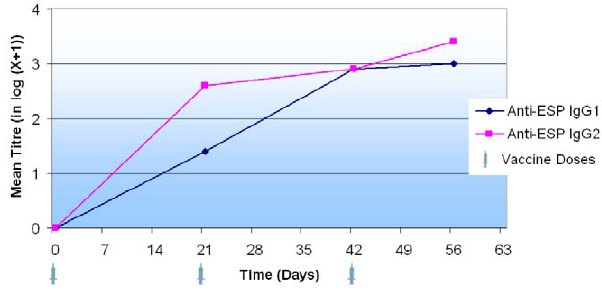
Figure 1. Progression in log-transformed anti-ESP IgG1 and IgG2 titres during the onset of immunity. The data presented here are the means of the log-transformed titres. The titre is taken to be the first dilution with an optical density of less than 0.4 measured at 405 nm. The sera were tested using an ESP-coated ELISA at days 0, 21, 42 and 56. The ESP used was identical in profile to the antigen of the vaccine.